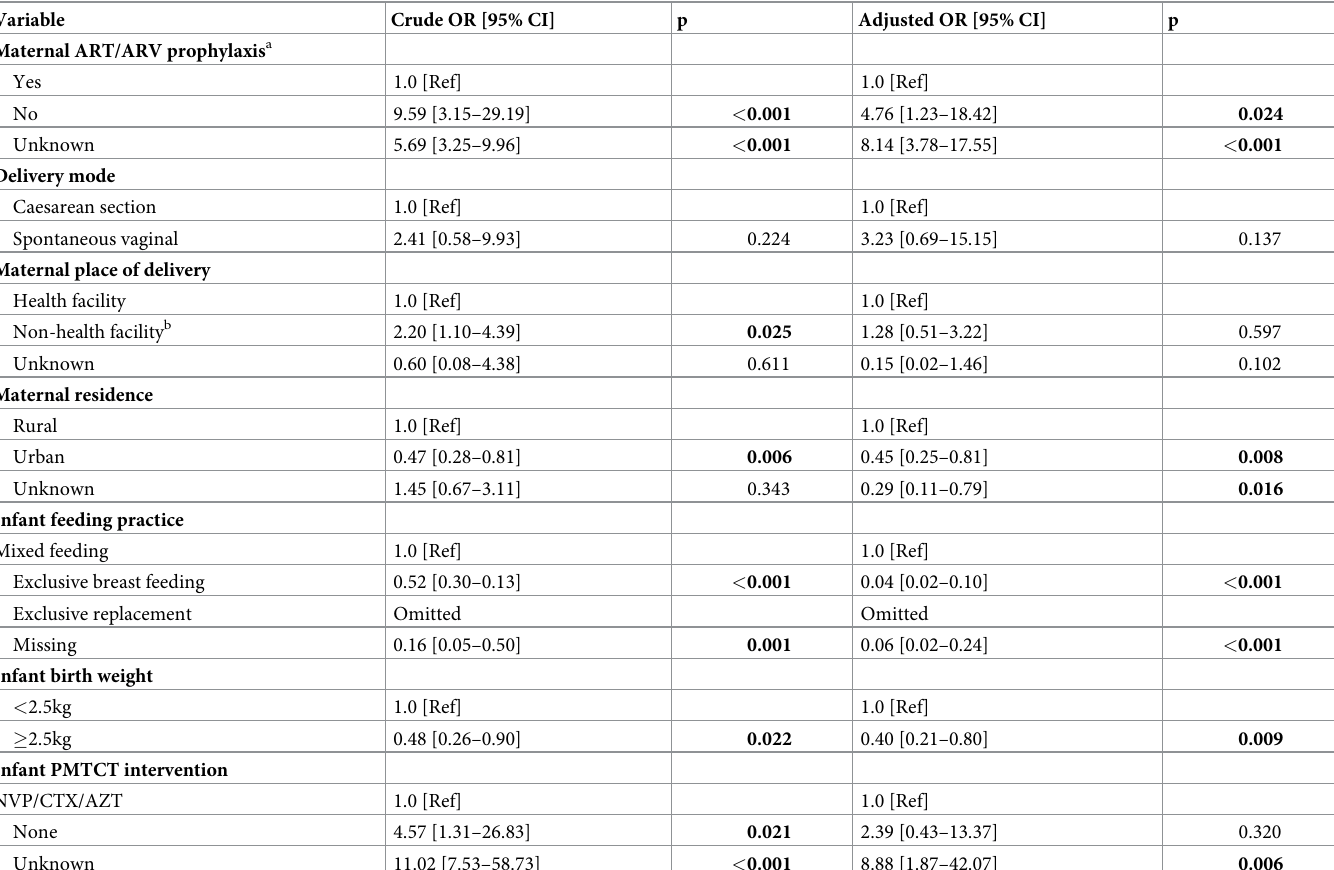
Table 3. Multivariate logistic regression analysis for predictors of final HIV outcomes of HIV-exposed